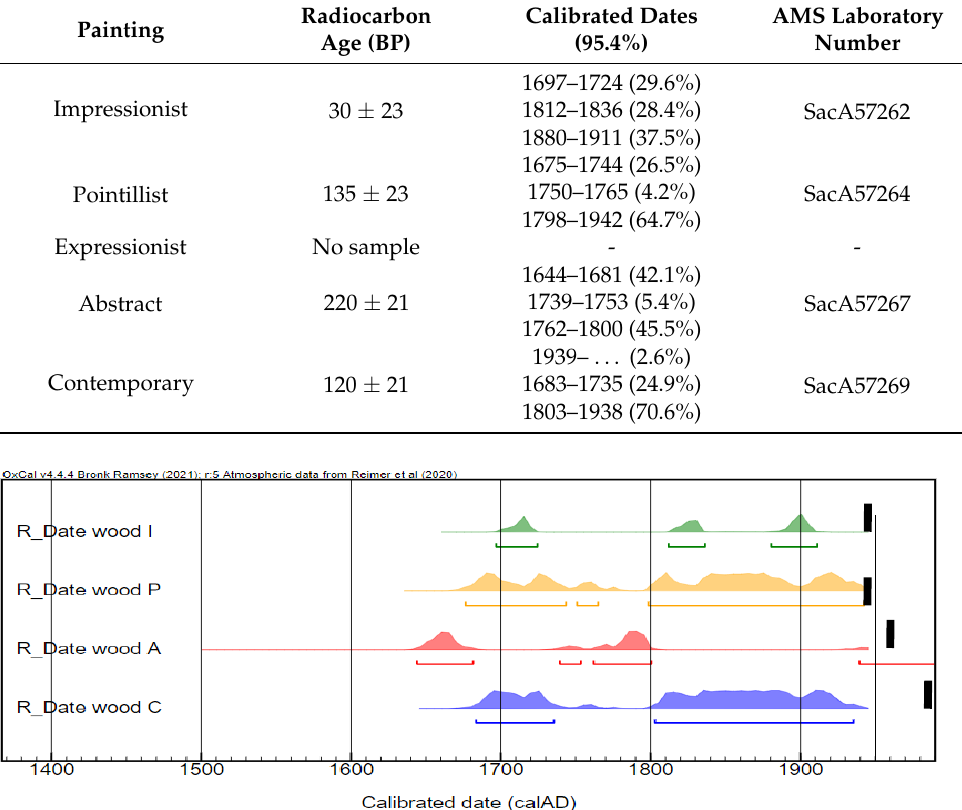
Table 3. 14 C accelerator mass spectrometry ( AMS) dating results of the wood samples taken from the painting stretchers. Uncalibrated radiocarbon ages are reported in years Before Present (BP), i.e., in years before 1950. Calibrated dates are obtained by calibrating the radiocarbon ages using the Intcal20 atmospheric curve [26] (Figure 7).